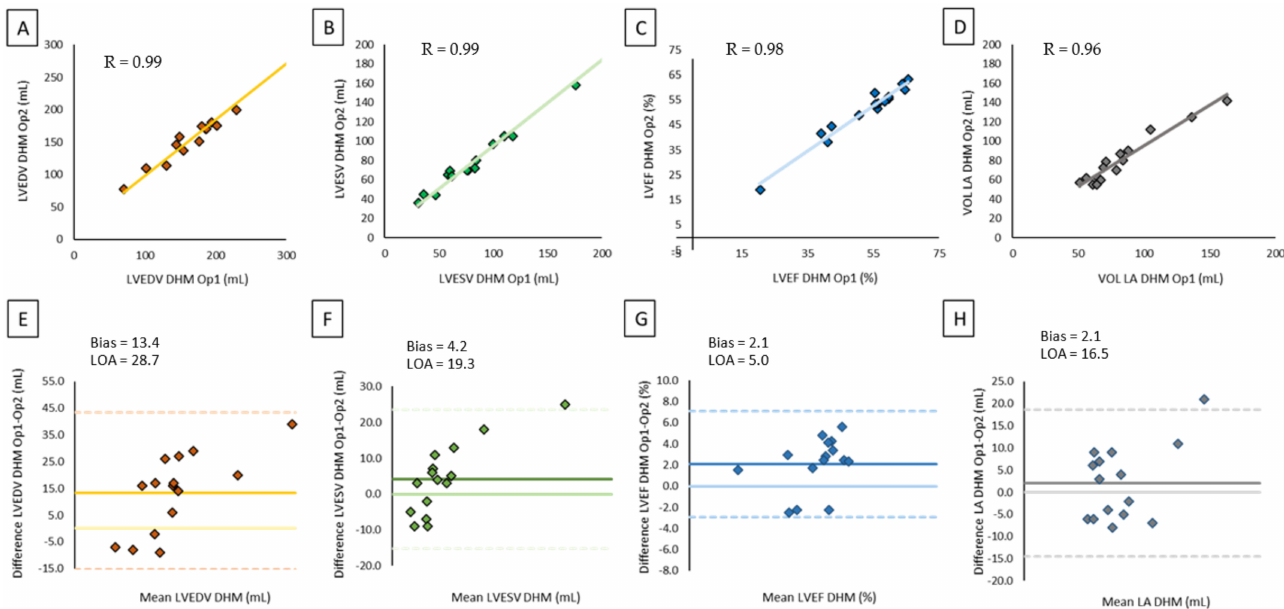
Figure 5. Intraobserver and interobserver